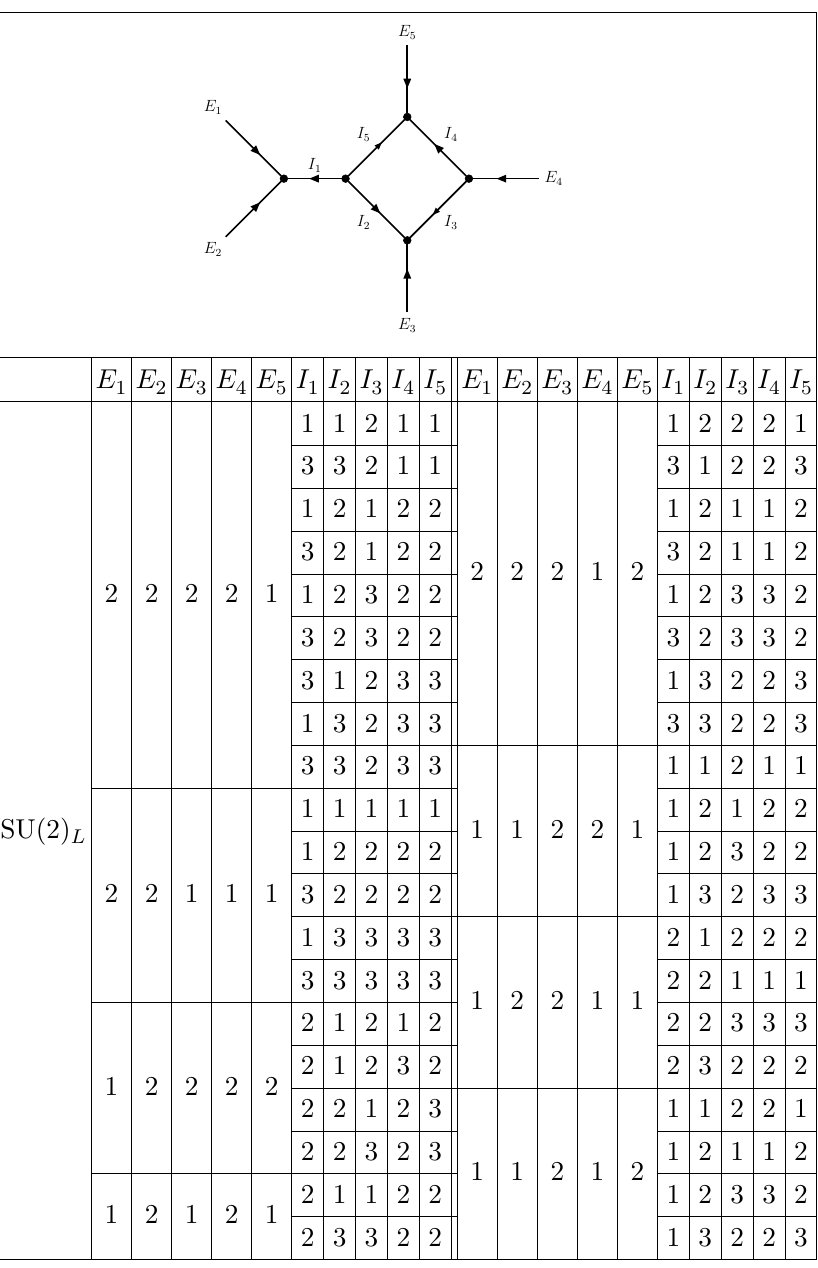
Table 7. The independent SU(2) and SU(3) quantum number assignments for the topology L C NL-1-2, where E and I denote the external fields and internal fields respectively. Other assignments i i are related to these in the table through permutations of external and internal lines ( continues...